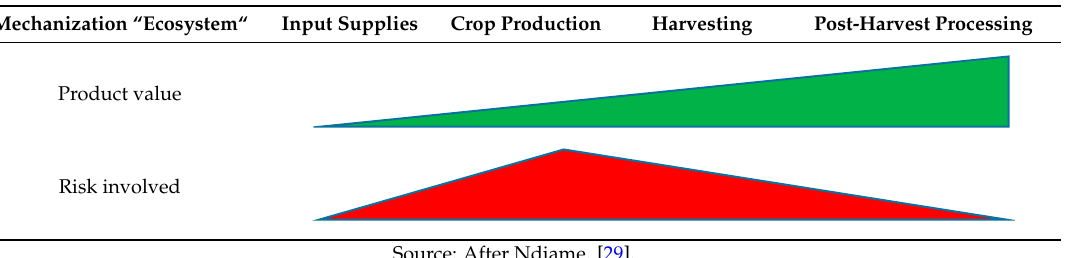
Table 4. Product value and risk levels along the agricultural produce value chain.